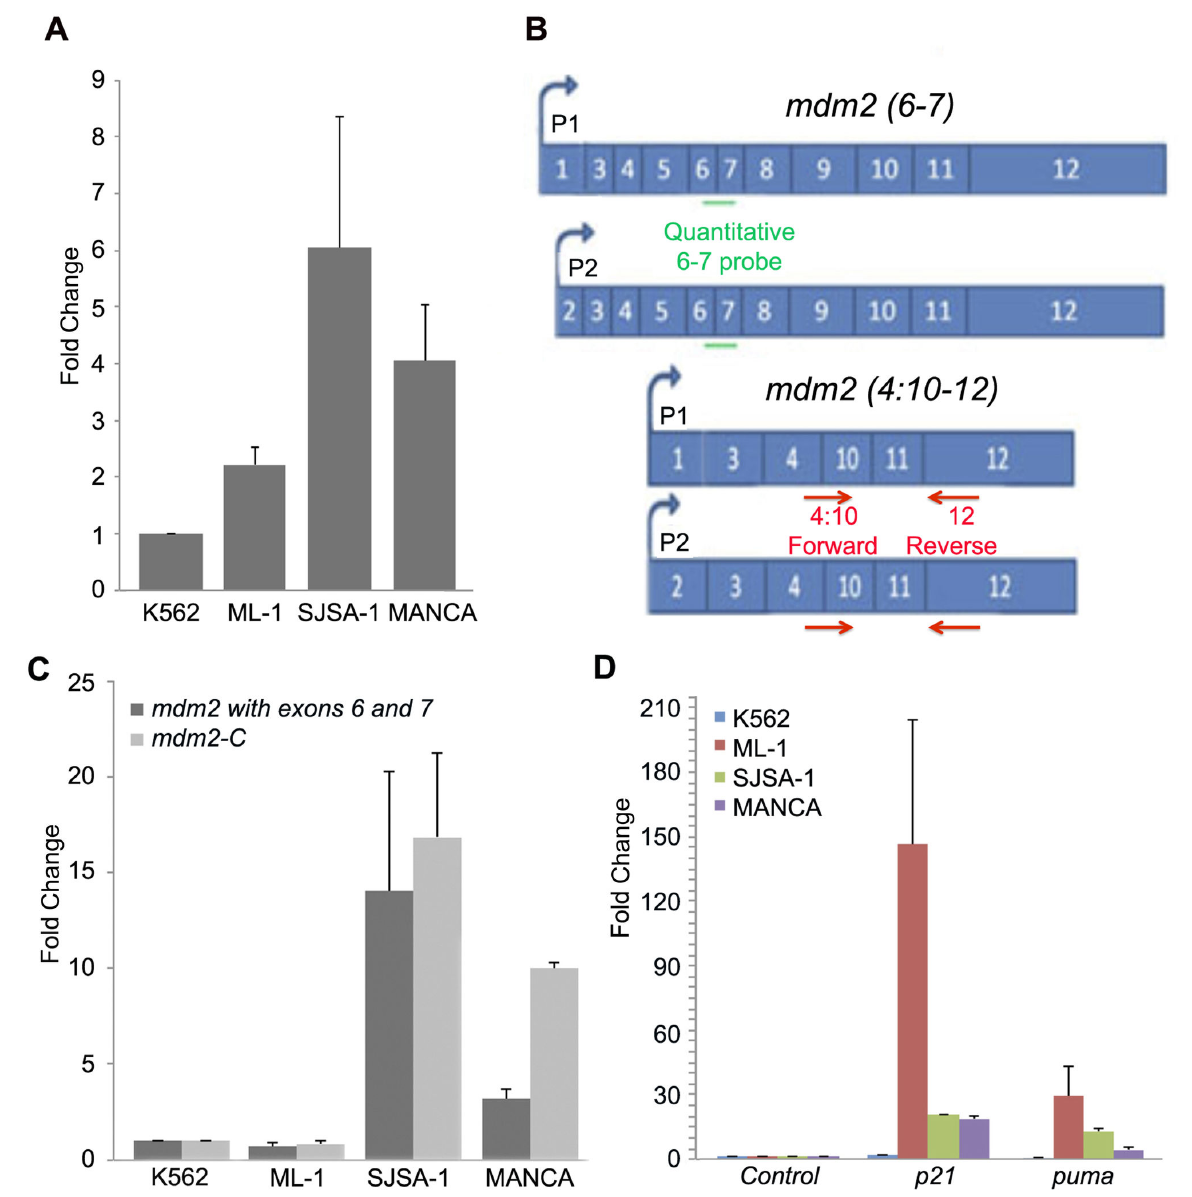
Figure 1. An mdm2 splice variant transcript, mdm2-C is highly expressed in MDM2 over-expressing cells. A . Quantitation using Image J after northern blot analysis of RNA from untreated MANCA, SJSA-1, ML-1 and K562 cell samples. An mdm2 DNA probe to exon 12 was PCR generated and radiolabelled with α 32 P dCTP. Transcript levels were compared to K562 for basal expression and normalized for RNA levels to gapdh . An average of four independent experiments is shown. Error bars indicate standard